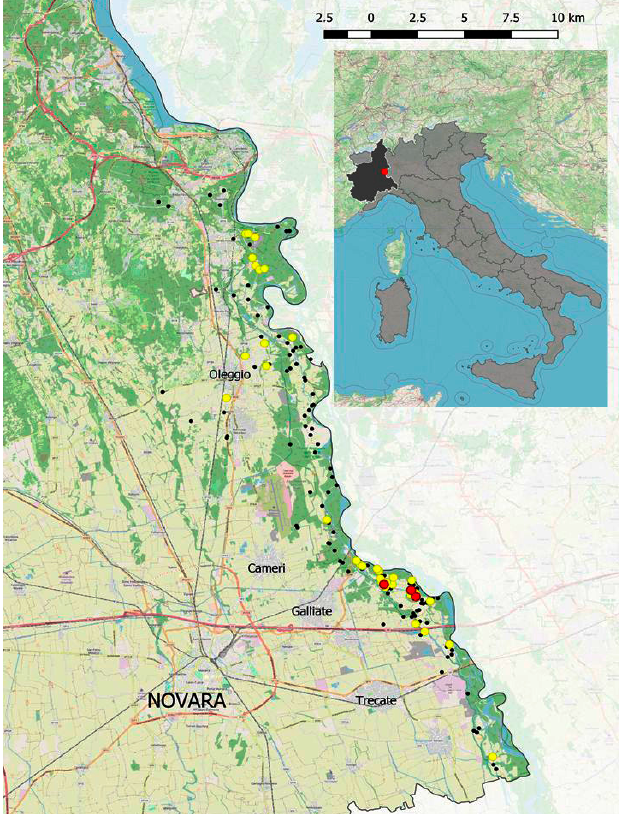
Figure 1. Entomopathogenic nematodes sampling sites map in an area infested by Popillia japonica in the Piedmont region (Northern Italy). Black points: sites without nematodes, yellow points: sites with Steinernema spp., red points: sites with Heterorhabditis bacteriophora .